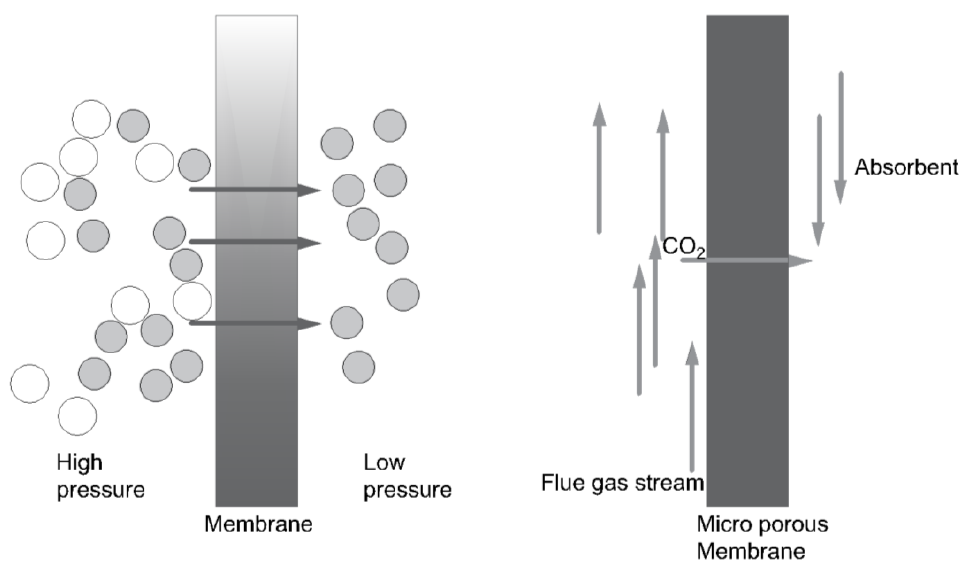
Figure 7. Principle of ( left ) a gas separation membrane, ( right ) a gas absorption membrane (based on [30]).